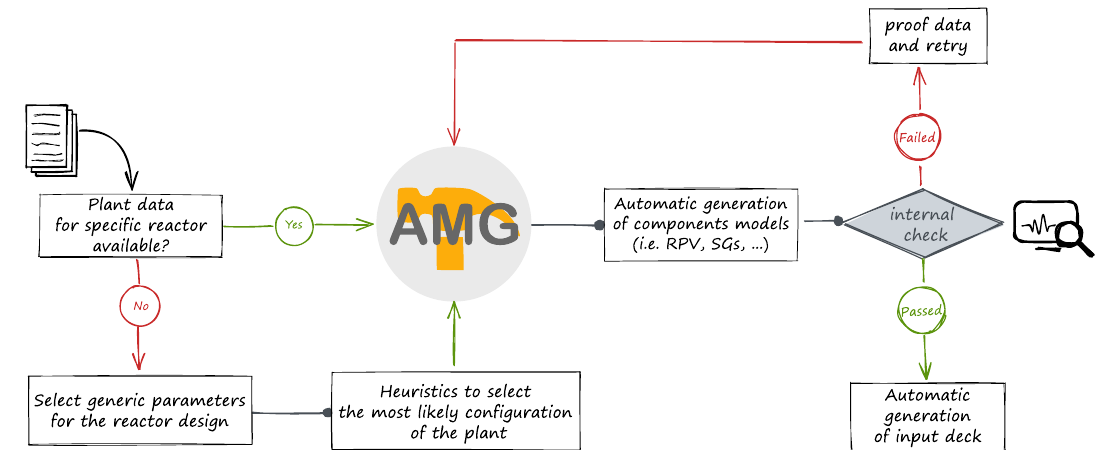
Fig. 4. Flow diagram for the Automatic Model Generator